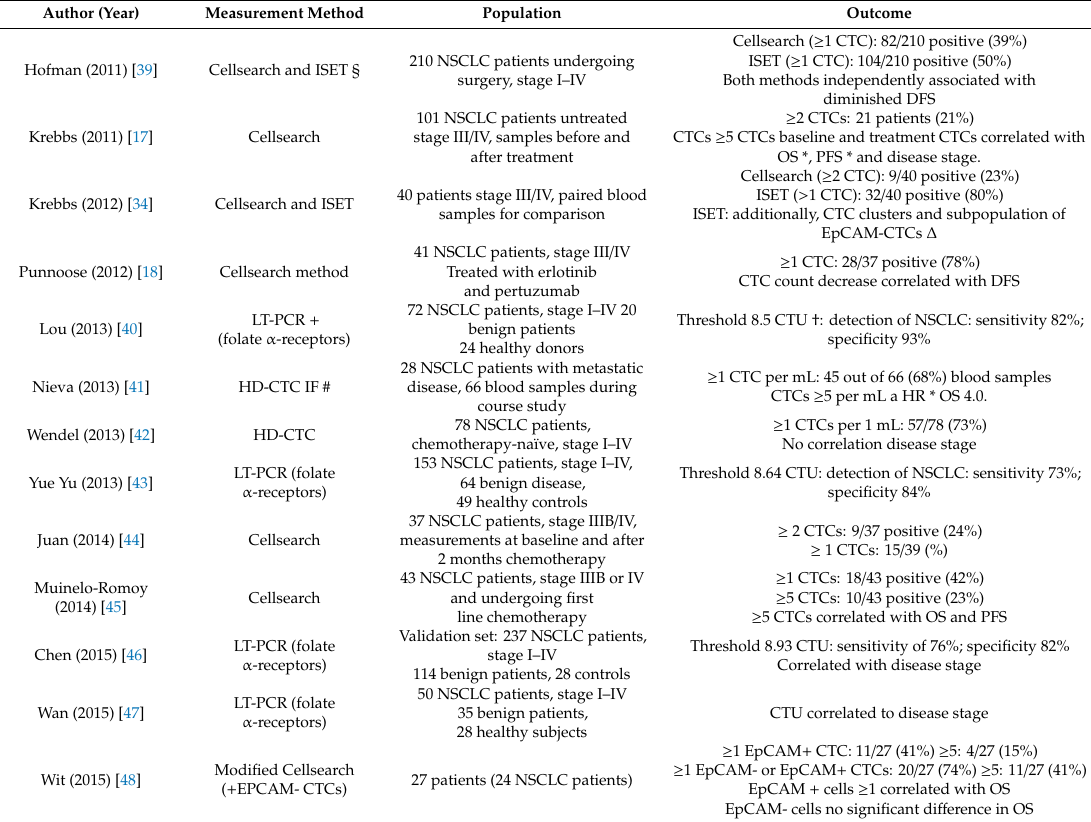
Table 1. Circulating tumor cells in non-small cell lung cancer (NSCLC) by di ff erent filtration techniques and the